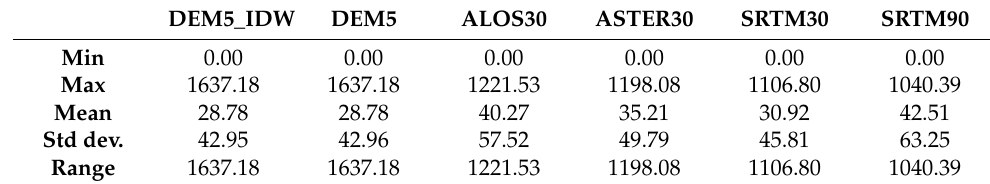
Table 10. The descriptive statistics of the annual soil loss (SE) (LS: CAL method) for each DEM.